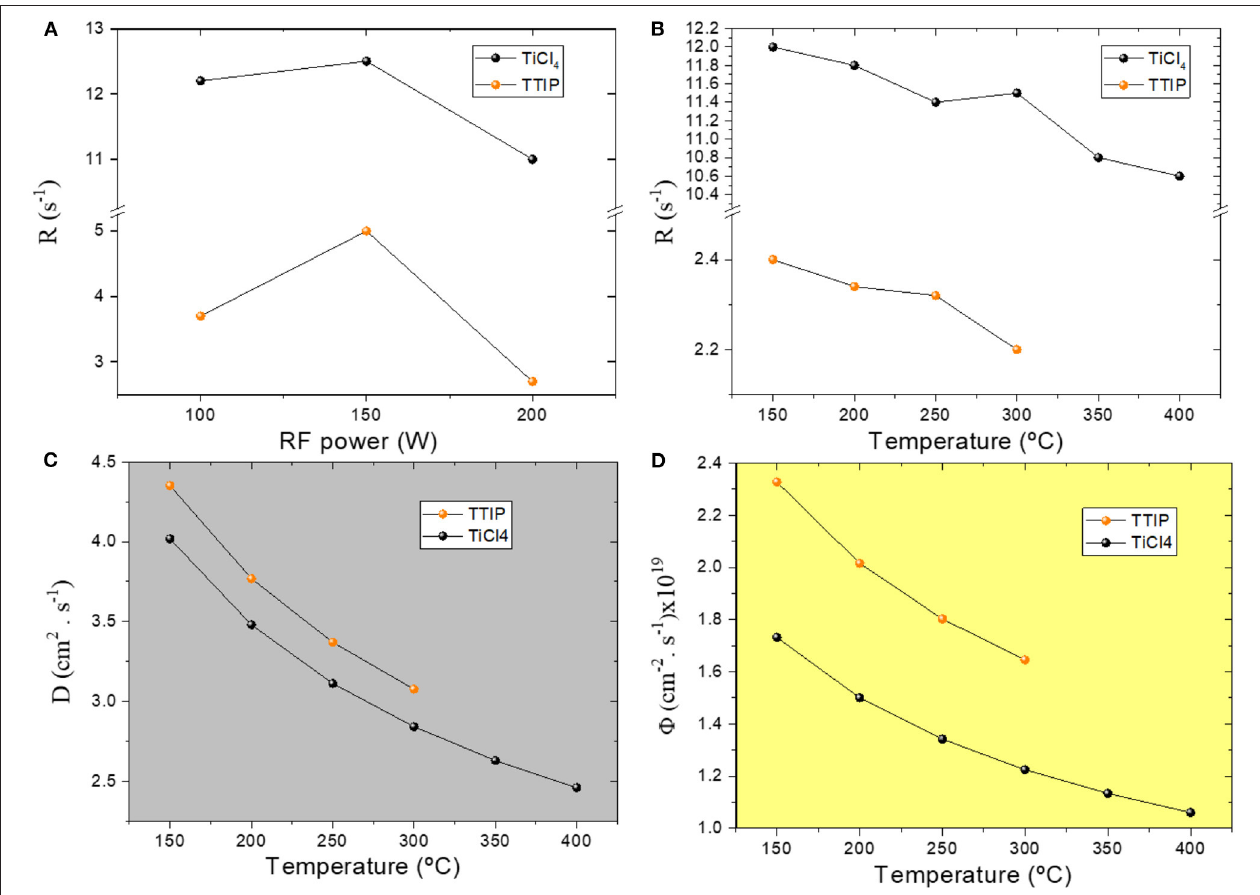
FIGURE 6 | Parameters extracted of the theoretical model applied at experimental data: (A) reaction rate [R(s − 1 )] vs. RF power, (B) reaction rate [R(s − 1 )] vs. temperature, (C) diffusion coefficient [